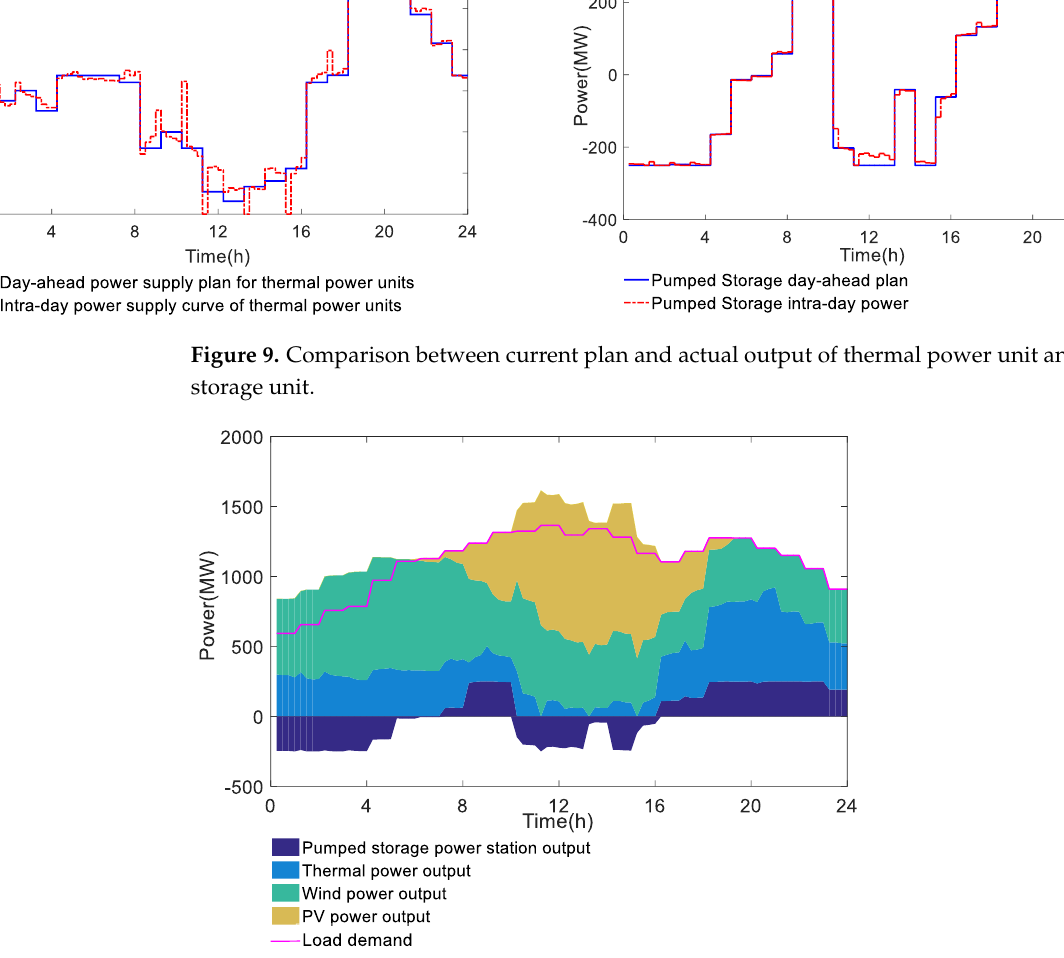
Figure 10. Revised actual output and load demand curves of each unit. The intra-day rolling optimization of the multi-source complementary power gener- ation system using intra-day ultra short-term forecast data can be seen to significantly lessen the impact on the intra-day scheduling results caused by the large error in the day- ahead forecast, as shown by the comparison curve between the intra-day output and the day-ahead plan. After the demand response was implemented, the load curve